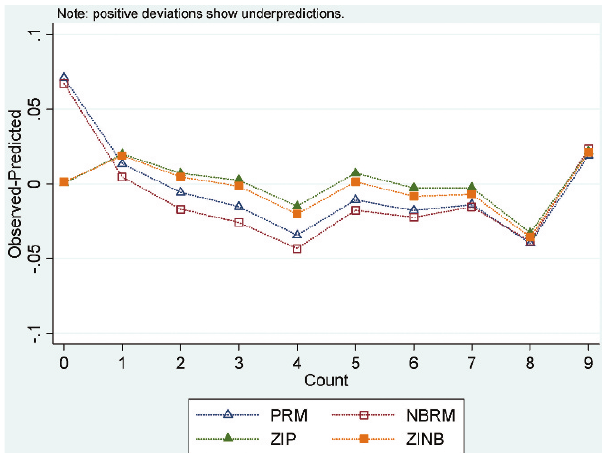
Figure 1 - Poisson (PRM), negative binomial (NBRM), zero- inflated Poisson (ZIP) and zero-inflated negative binomial (ZINB) regression models. The best model is closest to the zero